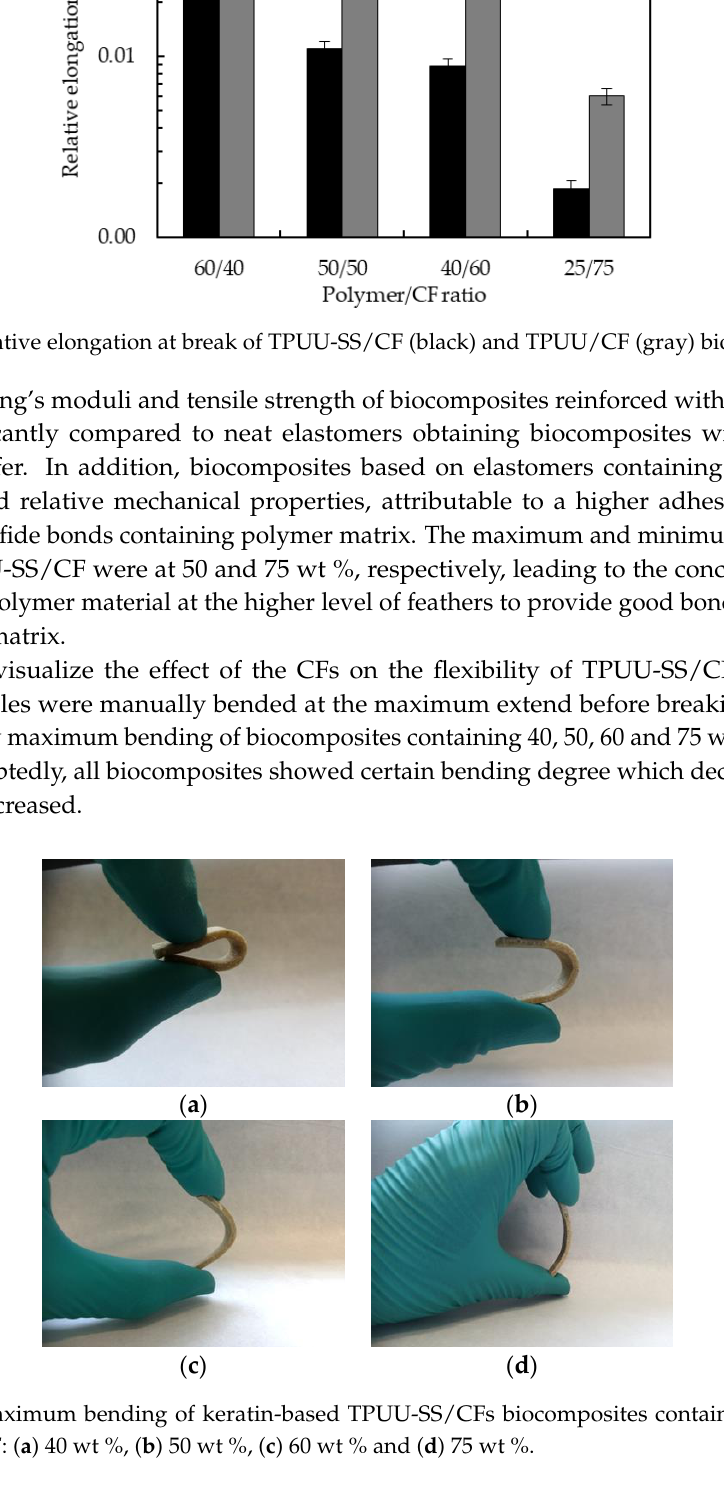
Figure 10. Maximum bending of keratin-based TPUU-SS/CFs biocomposites containing different loadings of CF: ( a ) 40 wt %, ( b ) 50 wt %, ( c ) 60 wt % and ( d ) 75 wt %.